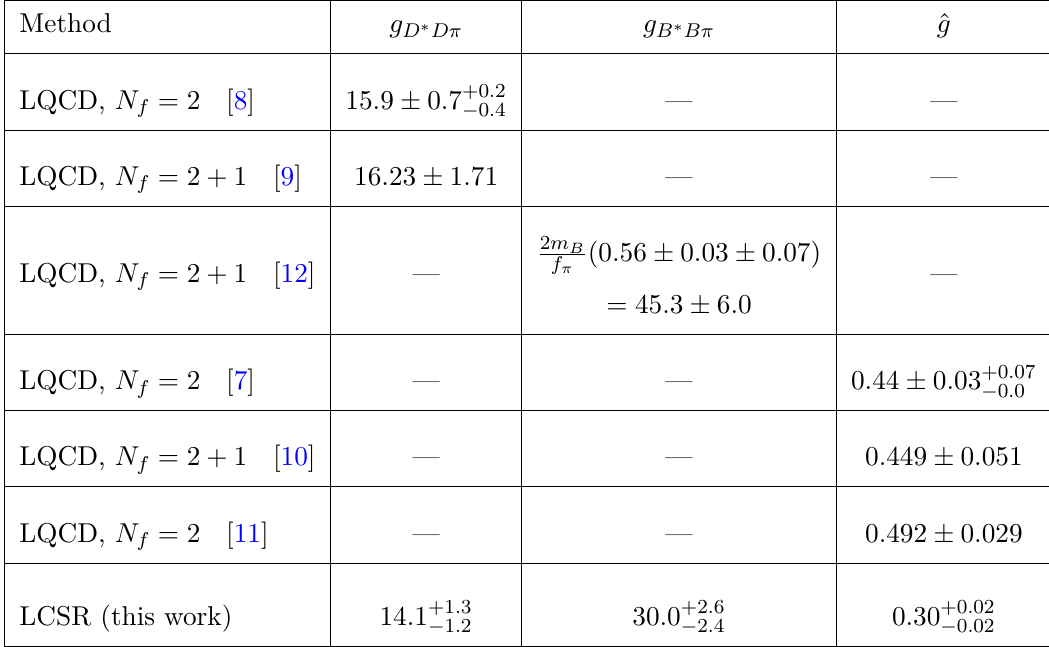
Table 7 . Strong couplings of the heavy mesons with pion obtained from lattice QCD (LQCD), compared with our LCSR prediction (using Model 1 of the pion DA and the lattice-QCD decay